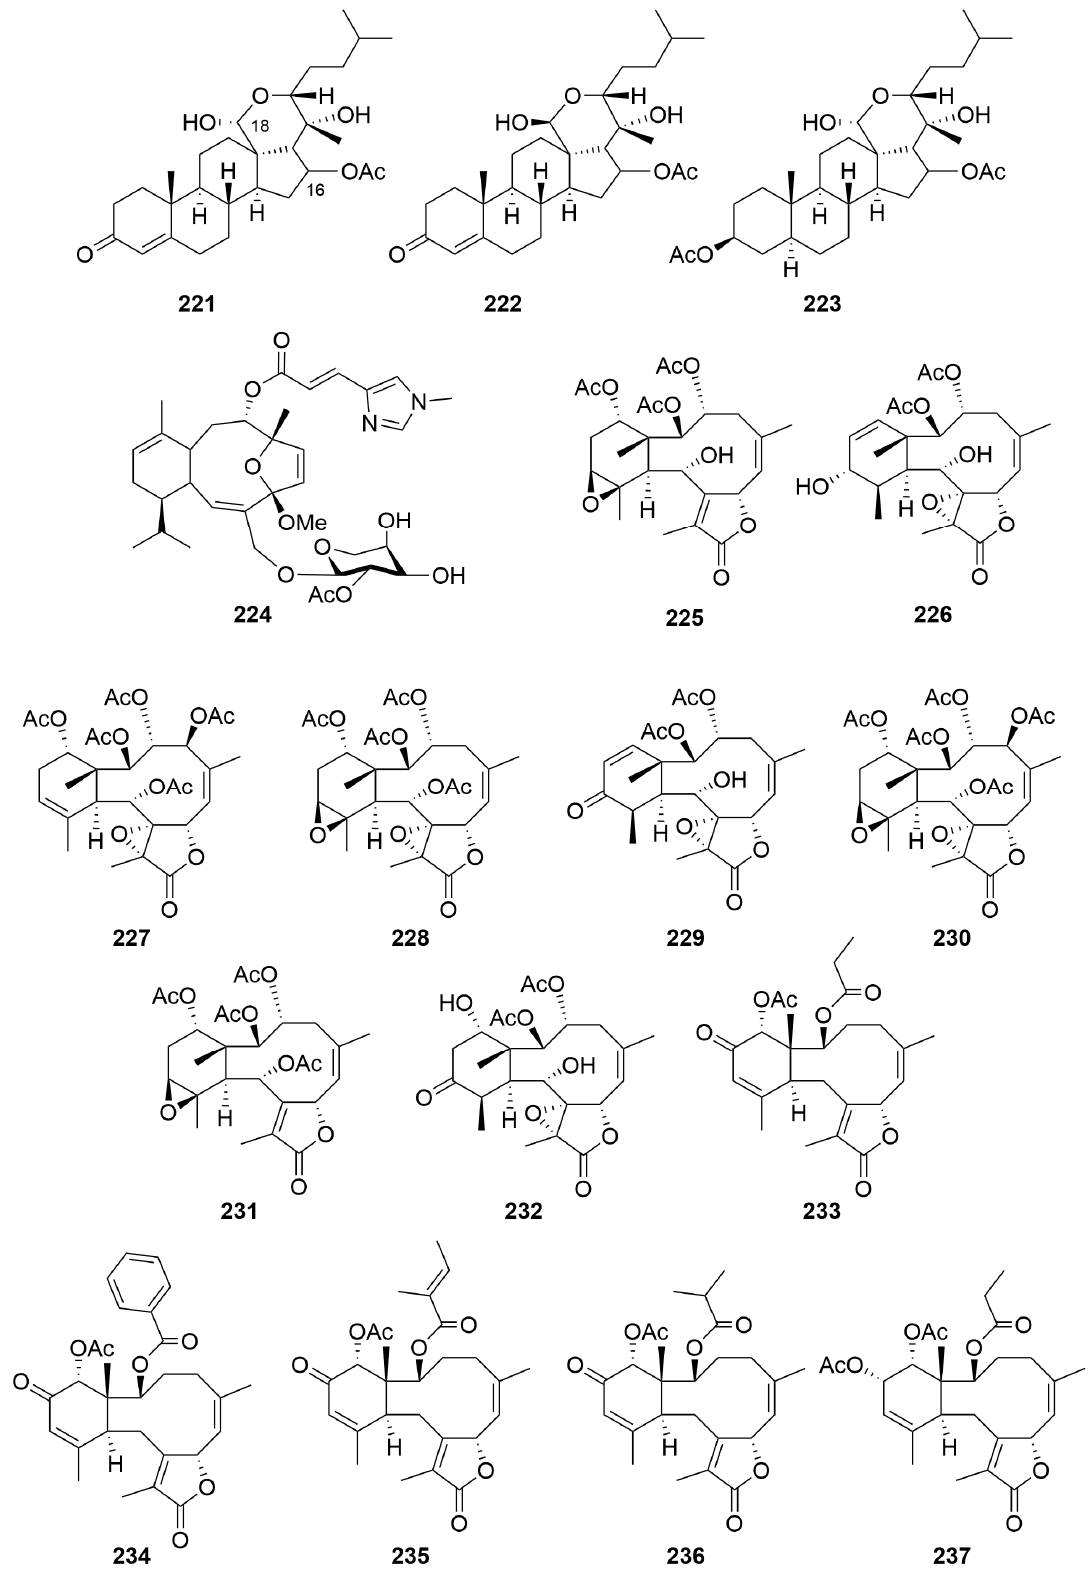
Figure 15. Compounds 221 to 237 . Bioassay-guided fractionation of a rare Alcyonacean soft coral Eleuthorobia sp. (Or- der: Alcyonacea; Family: Alcyoniidae), found near Bennett’s Shoal, yielded the new diter- pene glycoside eleutherobin ( 224 ) (Figure 15) [10]. The structure of 224 was assigned spec- troscopically. Eleutherobin ( 224 ) exhibited significant specific cytotoxicity against a di- verse panel of breast, renal, ovarian and lung cancer cell lines with an IC 50 range of 10–15 nM. Compound 224 was found to stabilize microtubules by competing for the paclitaxel binding site on the microtubule polymer [10]. Fractionation of a freeze-dried specimen of Briareum excavatum (Order: Alcyonacea; Family: Briareidae), collected at Rowley Shoals, afforded the known diterpene